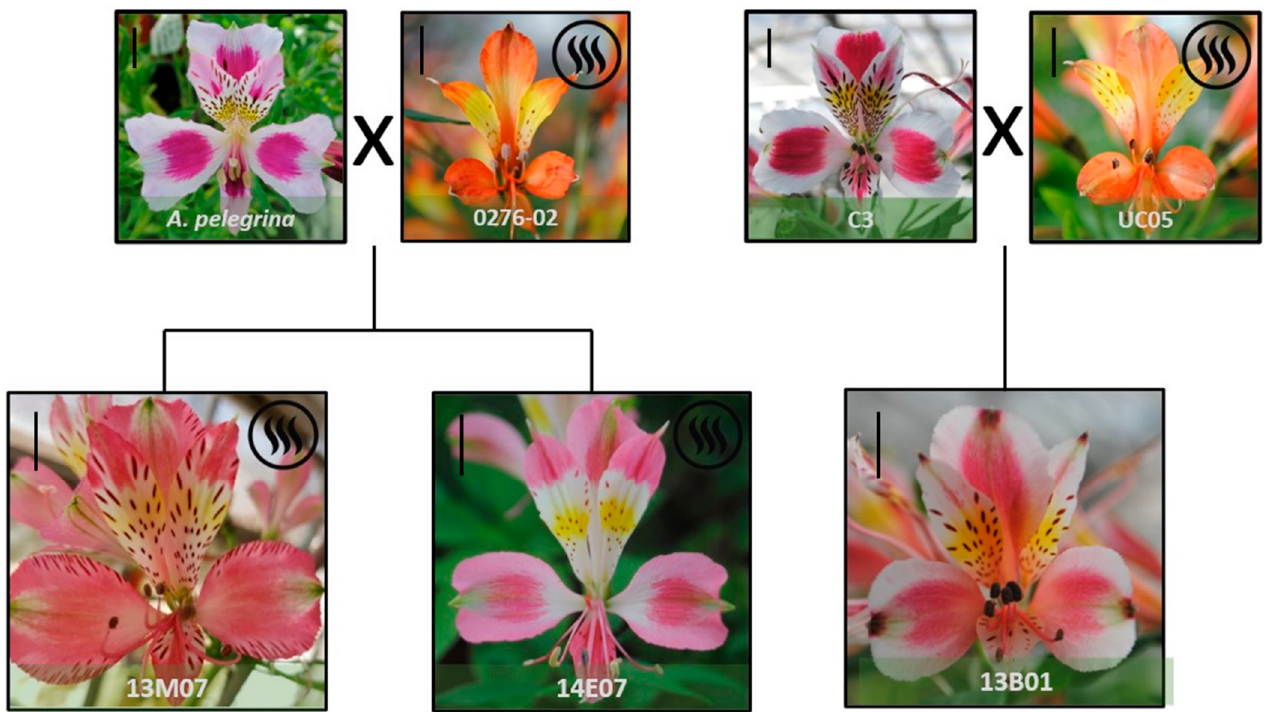
Figure 1. Scented (13M07 and 14E07) and non-scented (13B01) alstroemeria hybrids evaluated, showing their pedigree and floral morphology at stage S4 [26]. A scale bar (=1 cm) is included on the left upper corner of each picture.